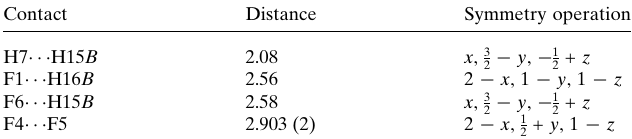
Table 2 Summary of short interatomic contacts (A˚ ) in